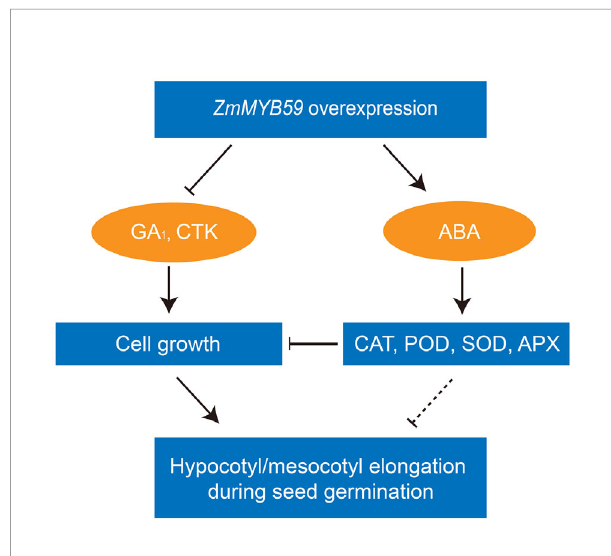
FIGURE 4 | The regulatory mechanisms of seed germination regulated by ZmMYB59 in tobacco and rice. GA 1 , CTK ABA represent gibberellin A1, cytokinin, abscisic acid, respectively. CAT, POD, SOD, APX represent catalase, peroxidase, superoxide dismutase, ascorbate peroxidase,